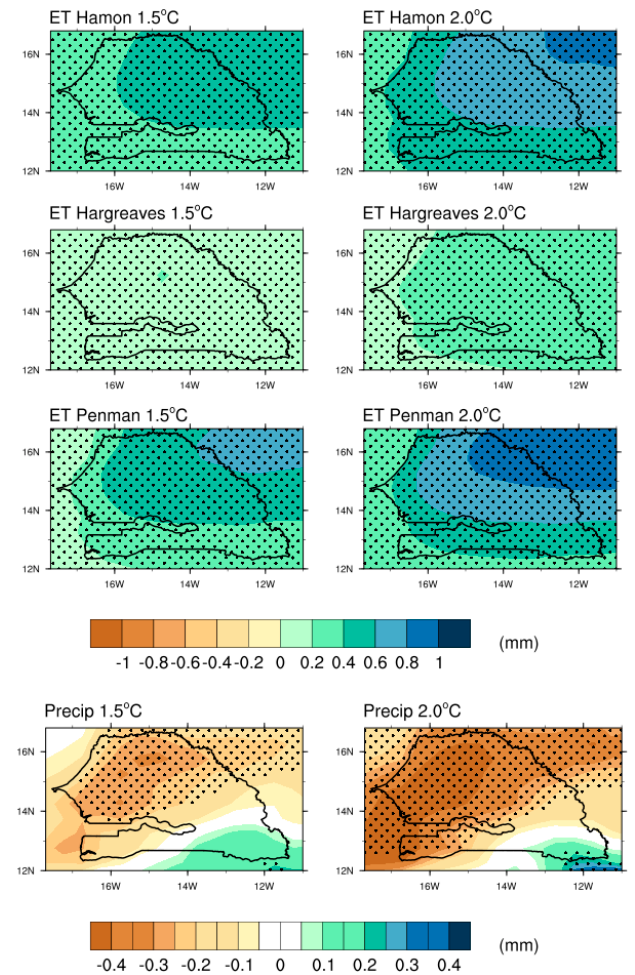
Figure 3. Seasonal evapotranspiration (ET, first row: Hamon, second row: Hargreaves, third row: Penman) and precipitation (Precip, fourth row) changes under 1.5 ◦ C ( left column ) and 2 ◦ C ( right column ) GWLs. Statistically significant changes (Student’s t -test) at 95% confidence level are represented by black dots.